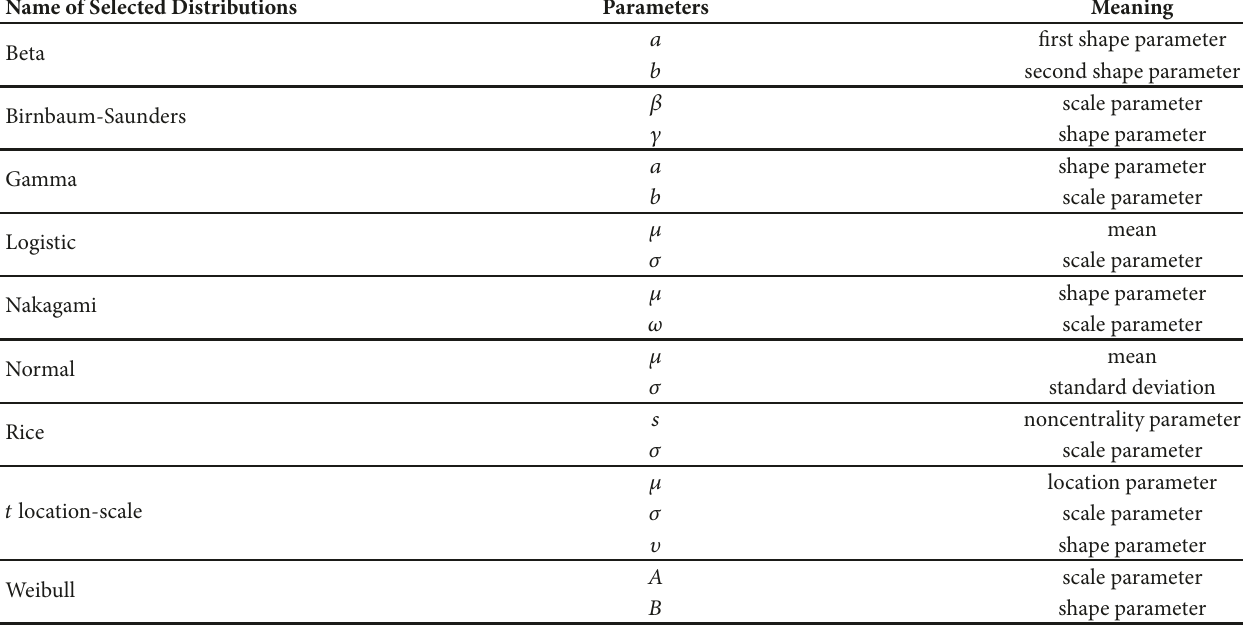
Table 1: A list of common distributions.